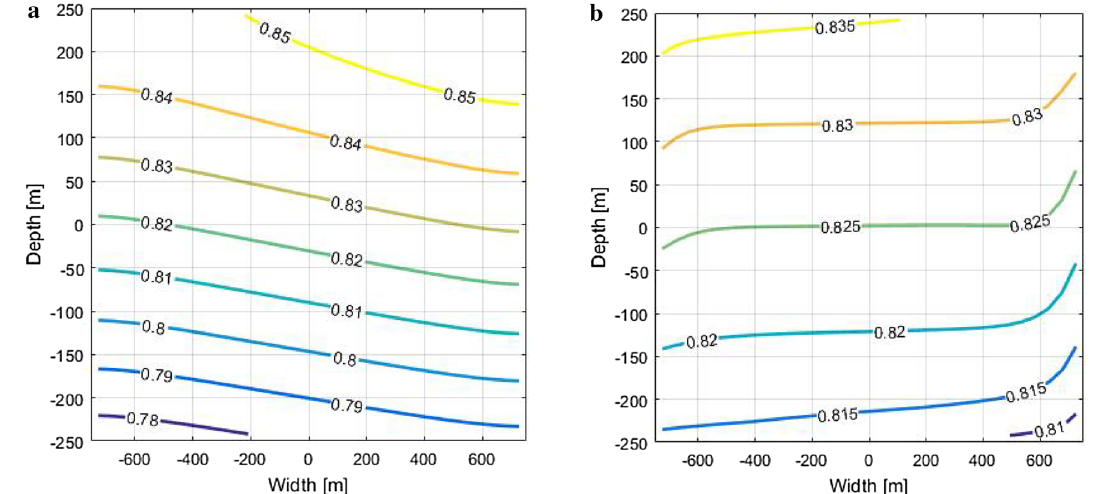
Fig. 6 a Contour plot of C 1 composition, convection free. b Contour plot of C 1 composition, with natural convection,